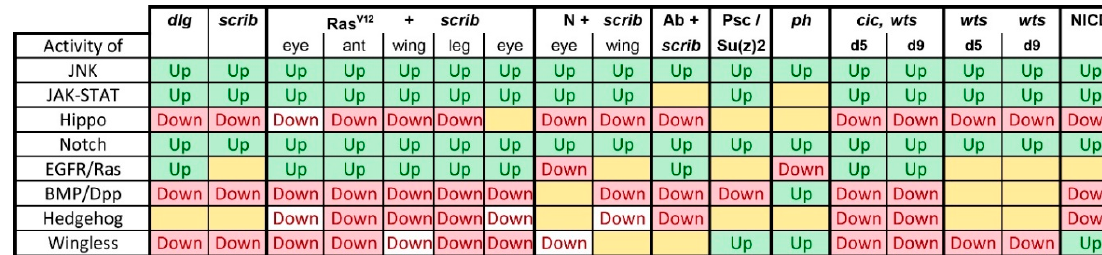
15 of 21 Figure 9. Expression of genes involved in apoptosis and cell cycle across tumors . Gene expression is displayed in log2FC. Color coding corresponds to a heatmap with a scale from − 5 (dark red) to 5 (dark green). Light grey cells represent non-significant changes with p > 0.05. Dark grey: the gene was not found in the datasets. Abbreviations: head involution defective, hid; repear, rpr; thread, th; string, stg; Cyclin A, CycA; E2F transcription factor 1, E2f1. 4. Discussion and Conclusions In the quest to develop better therapeutic approaches, there has been a push towards personalized medicine based on patients’ mutational status. The use of sophisticated statistical and computational analyses of genomic data from human tumors revealed large numbers of candidate genes and variants. While this has yielded some clear gains, it is often tough to interpret this big cancer data and to translate it to improved patient care [116]. The way forward will be paved by functional studies in experimental models to reveal the biological significance of the newly identified variants [117]. Here, we sought to determine if tumors with different known initiating mutations share common cell biology in the form of signal pathway activity. If so, this may indicate that unique mutational signatures converge on common signaling states to create tumors. By identifying common core signaling states, tumors may be stratified for potential treatment with novel inhibitor combinations. Owing to its demonstrated successes as an initial discovery platform as well as a